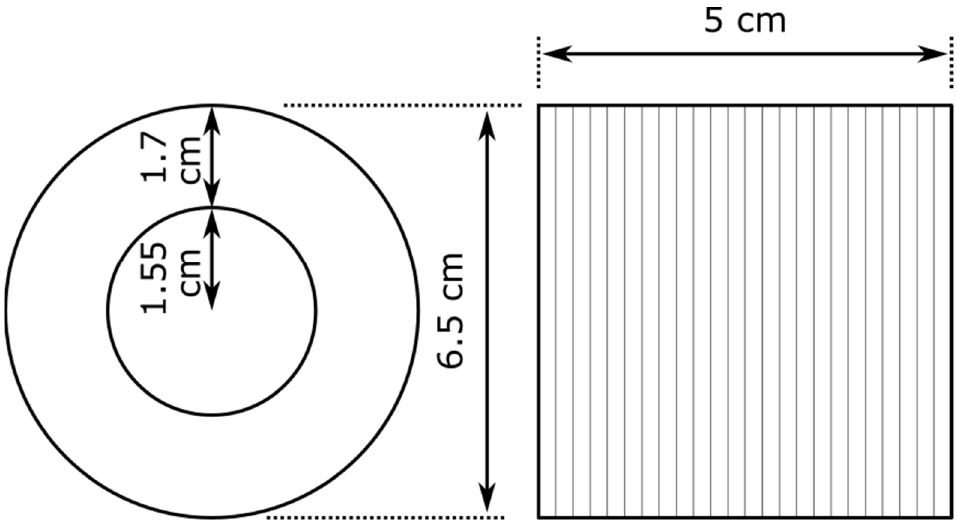
Figure 3. Coil dimensions used in N relays with two